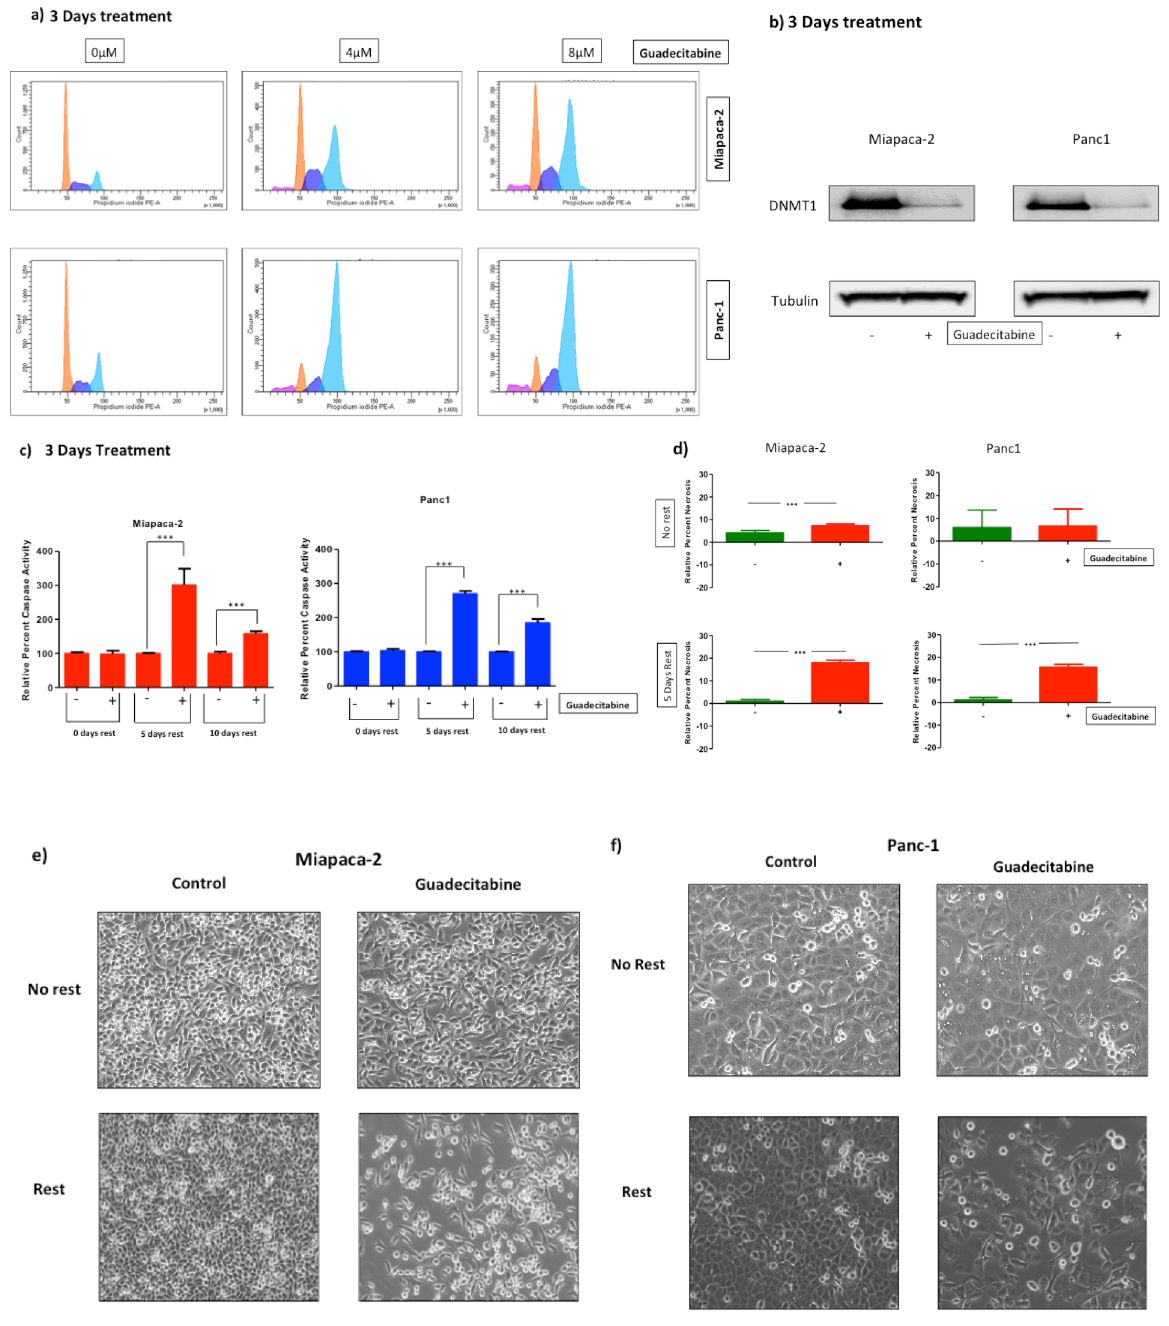
Fig 2. Effect of guadecitabine on DNA Methyltransferase 1, and its delayed response. Miapaca-2 and Panc1 were treated with guadecitabine (0–8 μM) for three days. The two cell lines were fixed and further stained with Propidium Iodide and analyzed using flow cytometry methods to evaluate cell cycle arrest. The pink color represents G0G1 phase, dark blue -S phase, and light blue -G2_M phase, respectively. The data was analyzed using DIVA software (a). Pancreatic cells were treated with guadecitabine at 0.14x10 -3 μM (b-f) for 3 days. Levels of DNMT1 expression were measured via Western blotting following treatment (b). To quantify apoptotic activity, Caspase 3/7 levels were measured after 0, 5, or 10 days of rest. Each experimental value was compared with control and plotted in terms of percentages using Graph Pad Prism (c).The amount of necrosis was calculated using a LDH detection kit following treatment with no rest or rest (d). Images were taken for treated and untreated cells for Miapaca-2 and Panc1 at 10X magnification using EVOS cell imaging system (e-f).Statistical analysis was performed using a one-way ANOVA and significance measured with a Tukey’s multiple comparison test (c) or utilizing a non-parametric t test (d). Data represented shows mean ± SEM (2c-2d).